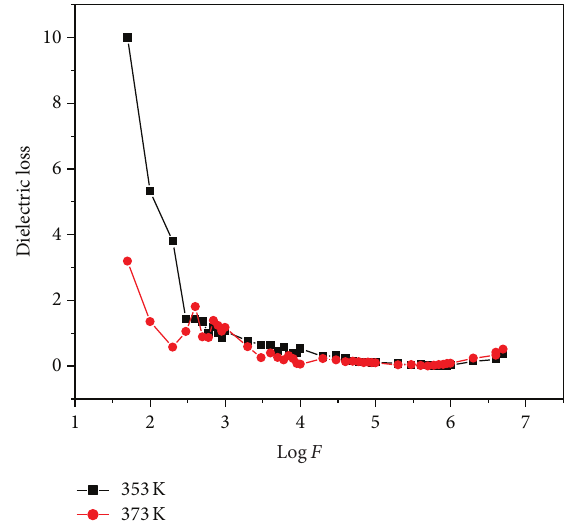
F 5: Variation of dielectric loss with frequency for different